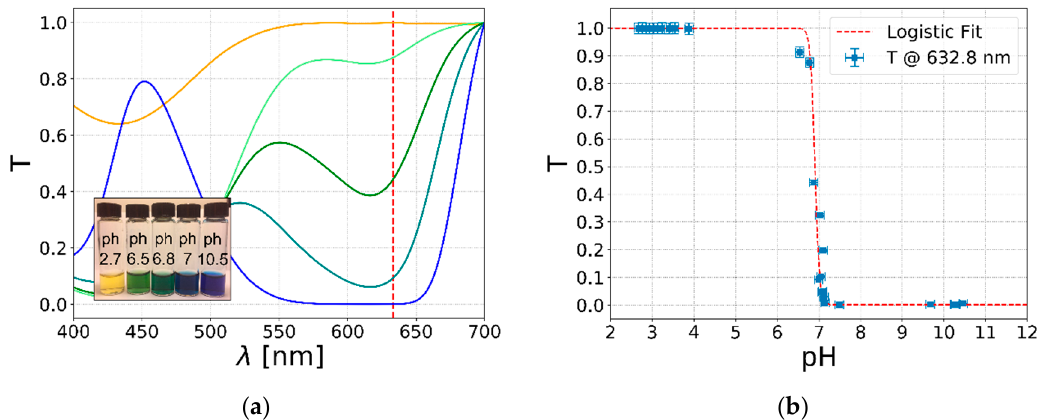
Figure 6. Spectral analysis for the Bromothymol Blue pH indicator. ( a ) The graph shows 5 spectra of solutions with different pHs; the line colors are related to the color assumed by the corresponding solution, referring to the inset. The red dashed line evidences 632.8 nm, which is the wavelength used for the pH sensing by the integrated LN device. ( b ) The graph reports the transmission at 632.8 nm for solutions at different pHs. At the transition, the transmission values present a sigmoidal behavior, which is confirmed by the interpolation of the data with an exponential logistic function (see Equation (1)).